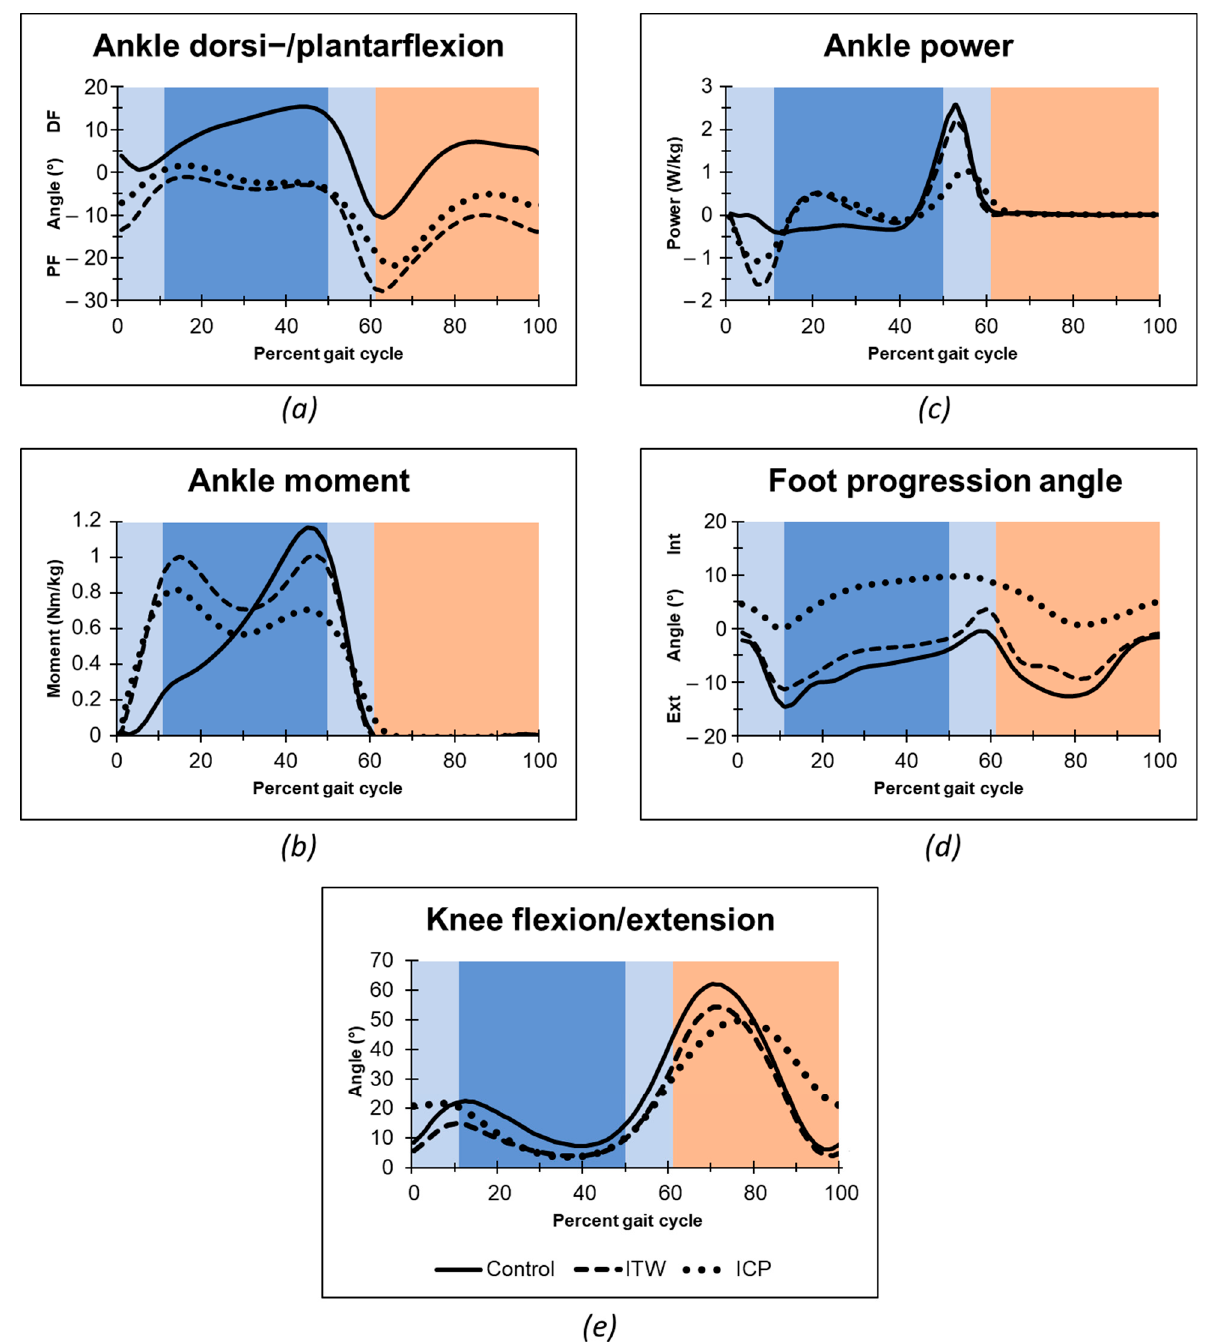
Figure 1. Gait analysis data of ankle angle ( a ), ankle internal moments ( b ), ankle power ( c ), foot progression angle ( d ), and knee angle in the sagittal plane ( e ). Mean algorithm is plotted for idiopathic toe walker (ITW), toe-walking children with cerebral palsy (CP), and typically developing peers. Gait Phases: Stance Phase (dark blue: Single Support Phase; light blue: Double Support Phase); Swing Phase (orange); Abbreviations: PF, Plantarflexion; DF, Dorsiflexion; Ext, External; Int, Internal.